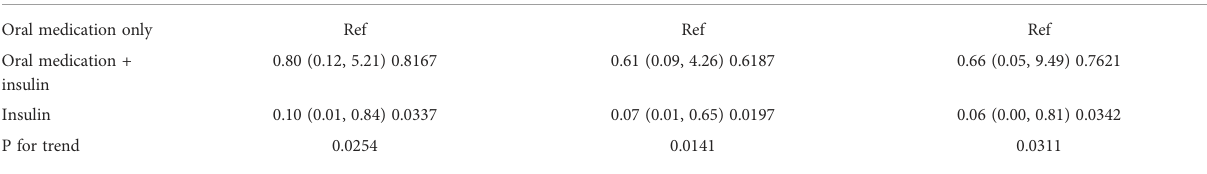
TABLE 3 Relationship between different hypoglycemic regimens and postoperative diabetic macular edema in different models.